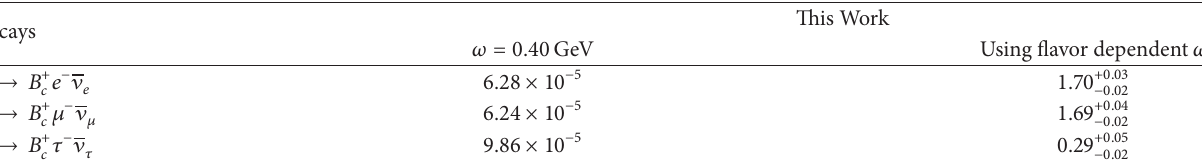
Table 9: Branching ratios (in the units of 10 −10 ) of Υ → 𝑃𝑙𝜈 decays.